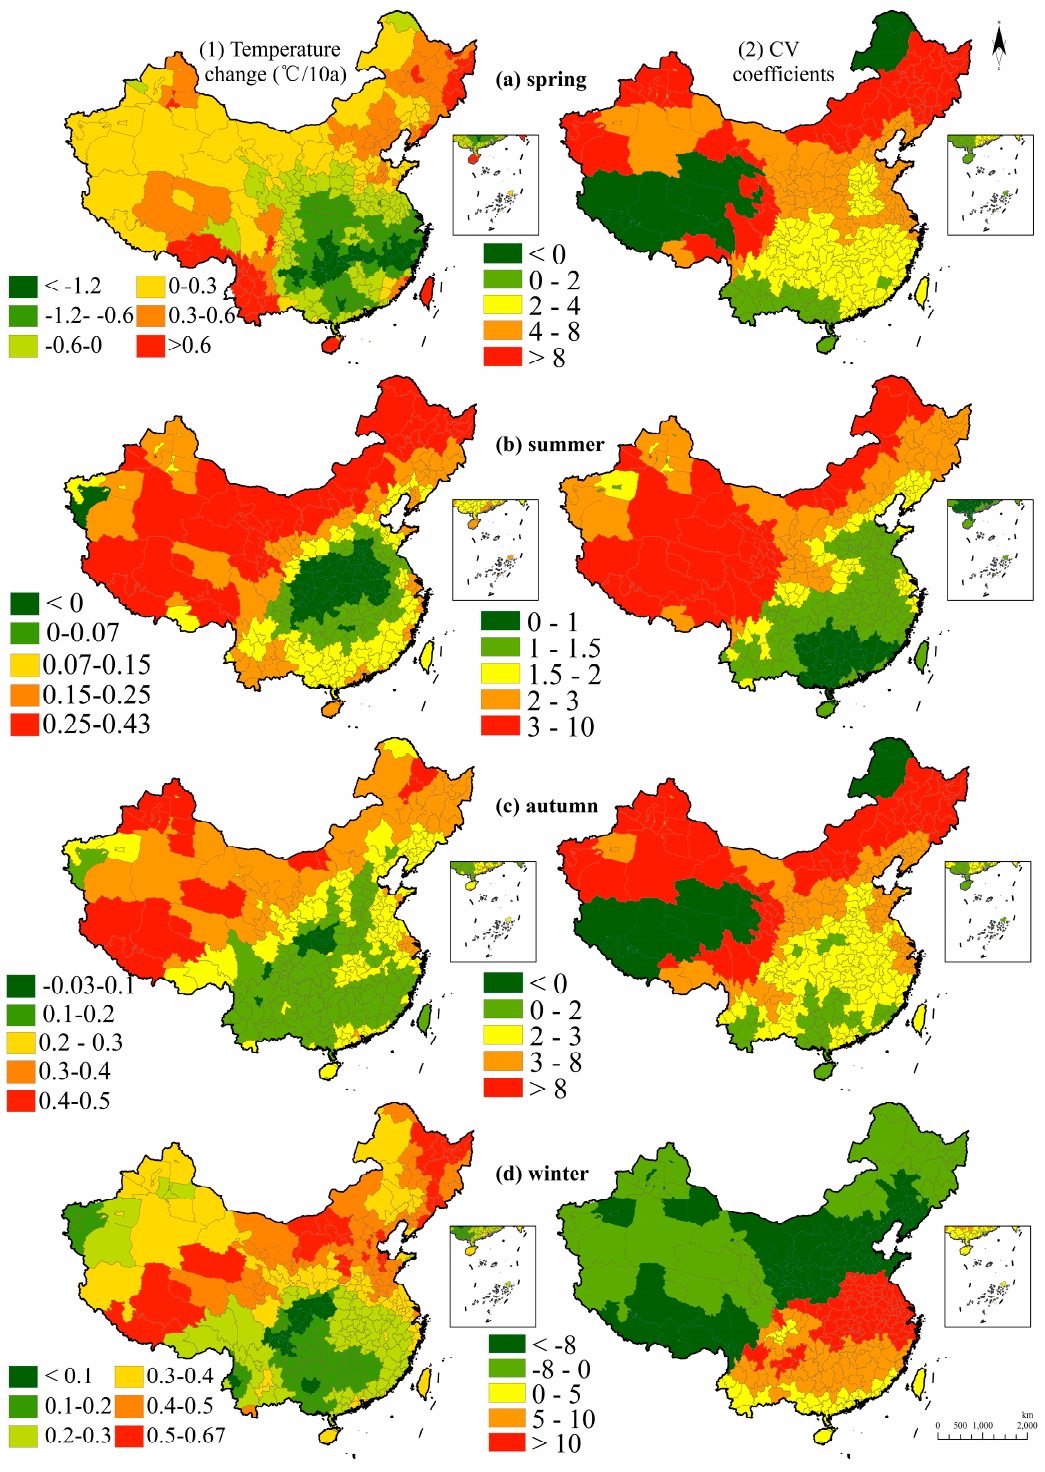
Figure 4. Seasonal temperature changes and fluctuations in 60 years. Note: ( a1 ) is for the temperature change in the spring and ( a2 ) is the CV coefficient. For the same period, ( b – d ) are corresponding to the temperature change and the CV coefficient in the summer, the autumn, and the winter.